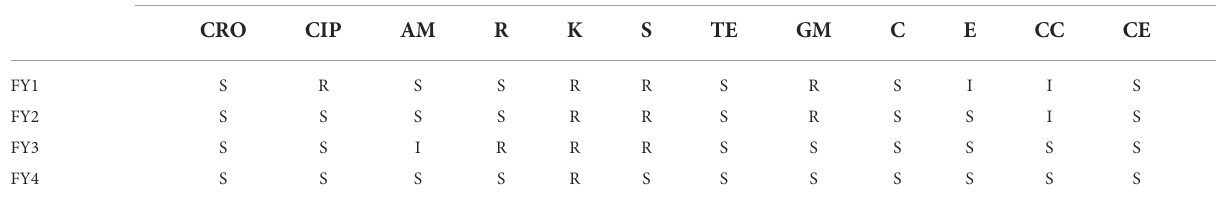
TABLE 3 Antibiotic susceptibility of selected LAB